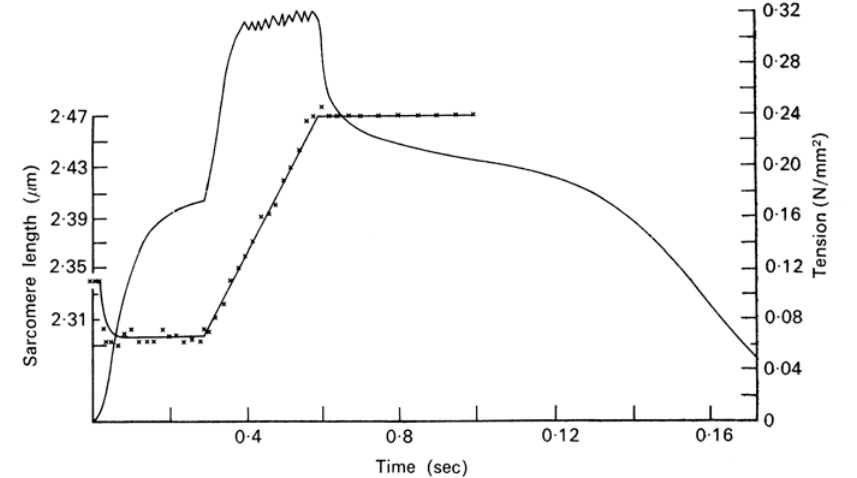
FIGURE 4. Effect of stretch on tension and sarcomere length during a tetanus. Measurements of sarcomere length (crosses) are superimposed on traced tension record (after Edman et